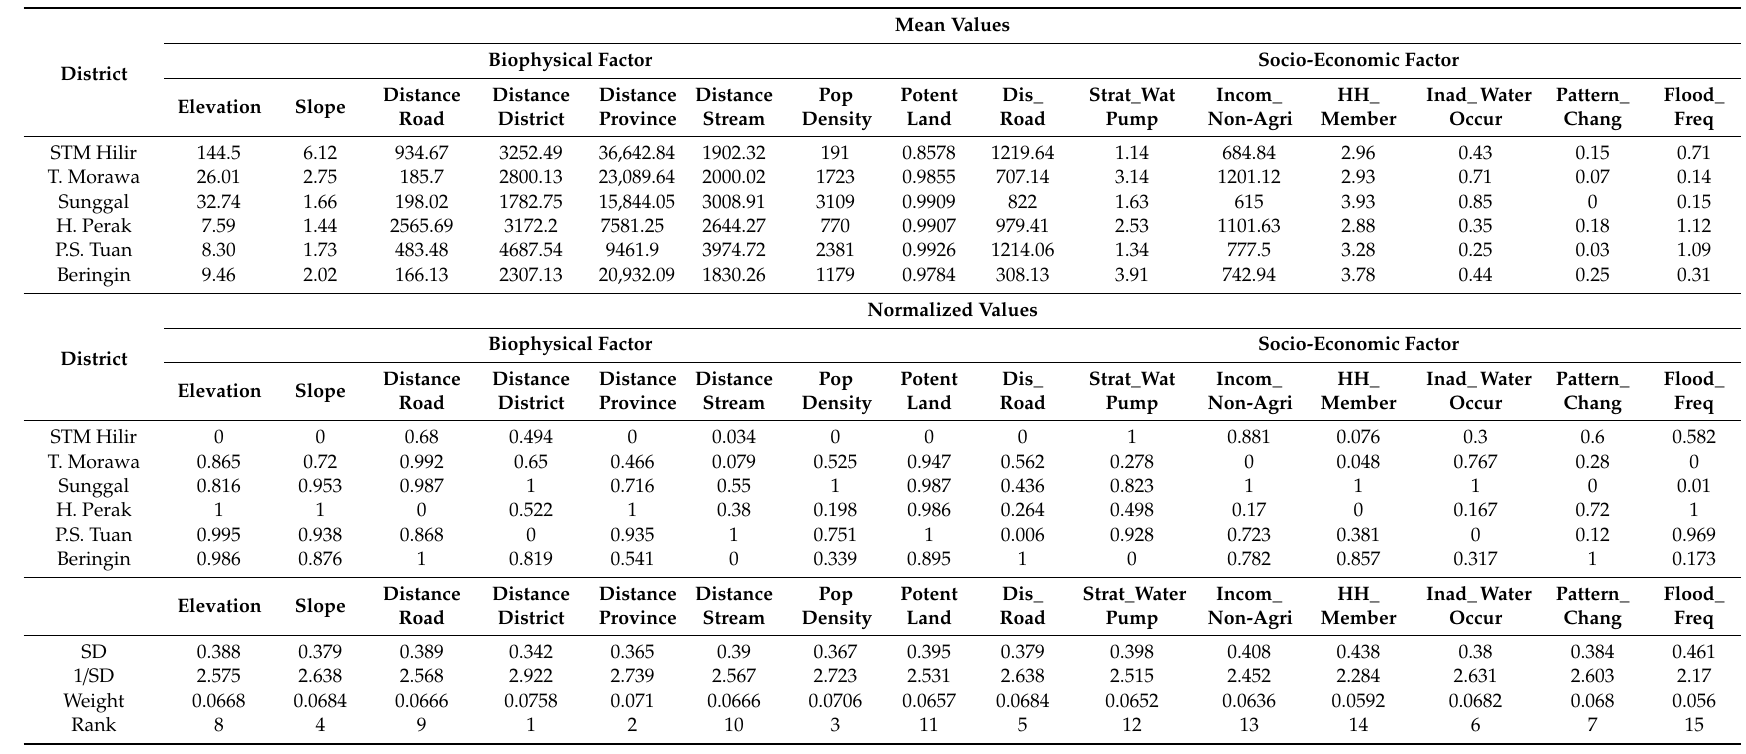
Table 14. The mean, normalized, and weighted values of the factors significantly influencing rice land